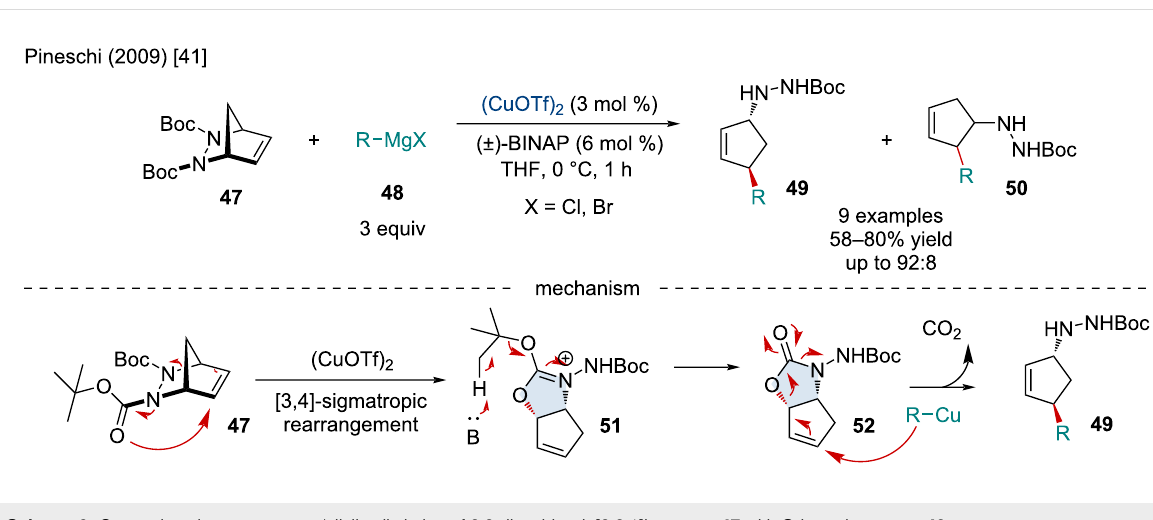
Scheme 8: Cu-catalyzed rearrangement/allylic alkylation of 2,3-diazabicyclo[2.2.1]heptenes 47 with Grignard reagents 48